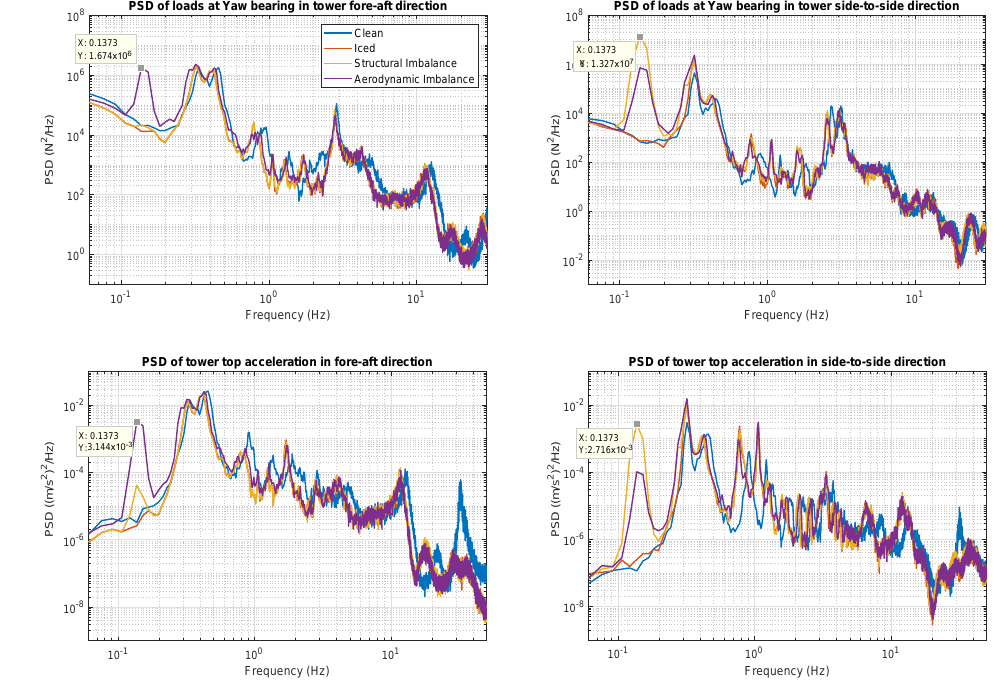
Figure 20. Influence of symmetrical and asymmetrical icing of the turbine blades on tower loads and vibration accelerations. Note: The frequency 0.1373 Hz (where a peak is marked) in the above plots corresponds to average rotational speed of the turbine in the